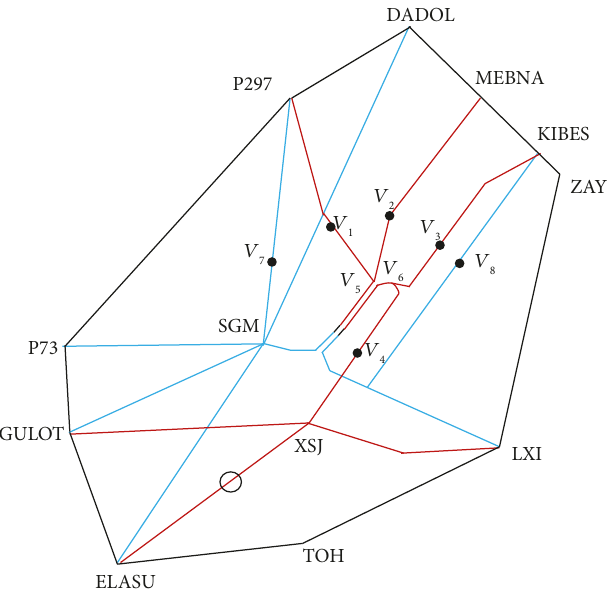
Figure 6: Terminal airspace under weather condition